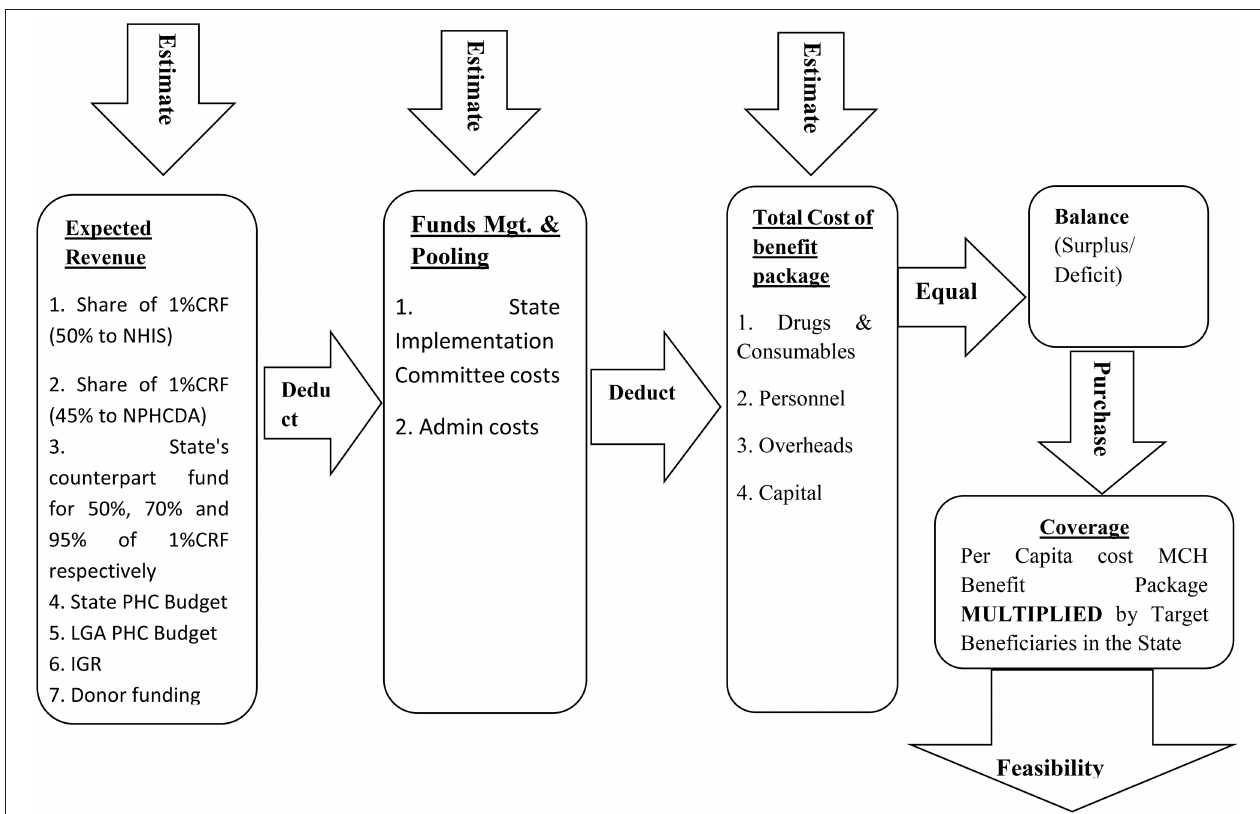
FIGURE 1 | Steps in undertaking financial